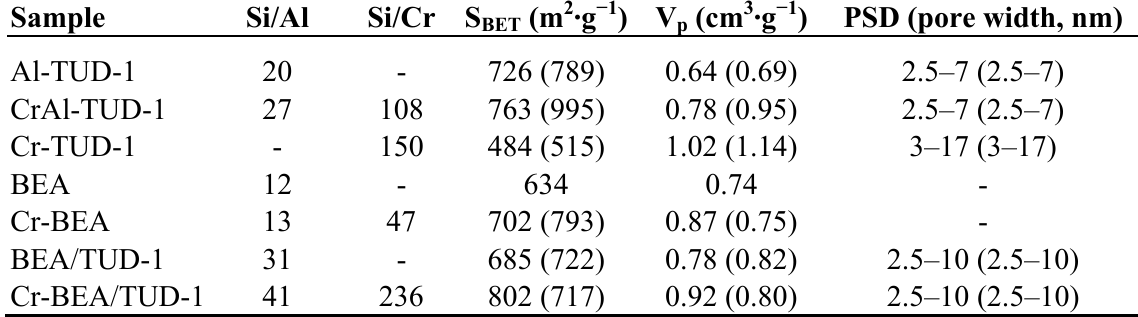
Table 1. Physicochemical properties of the prepared materials a